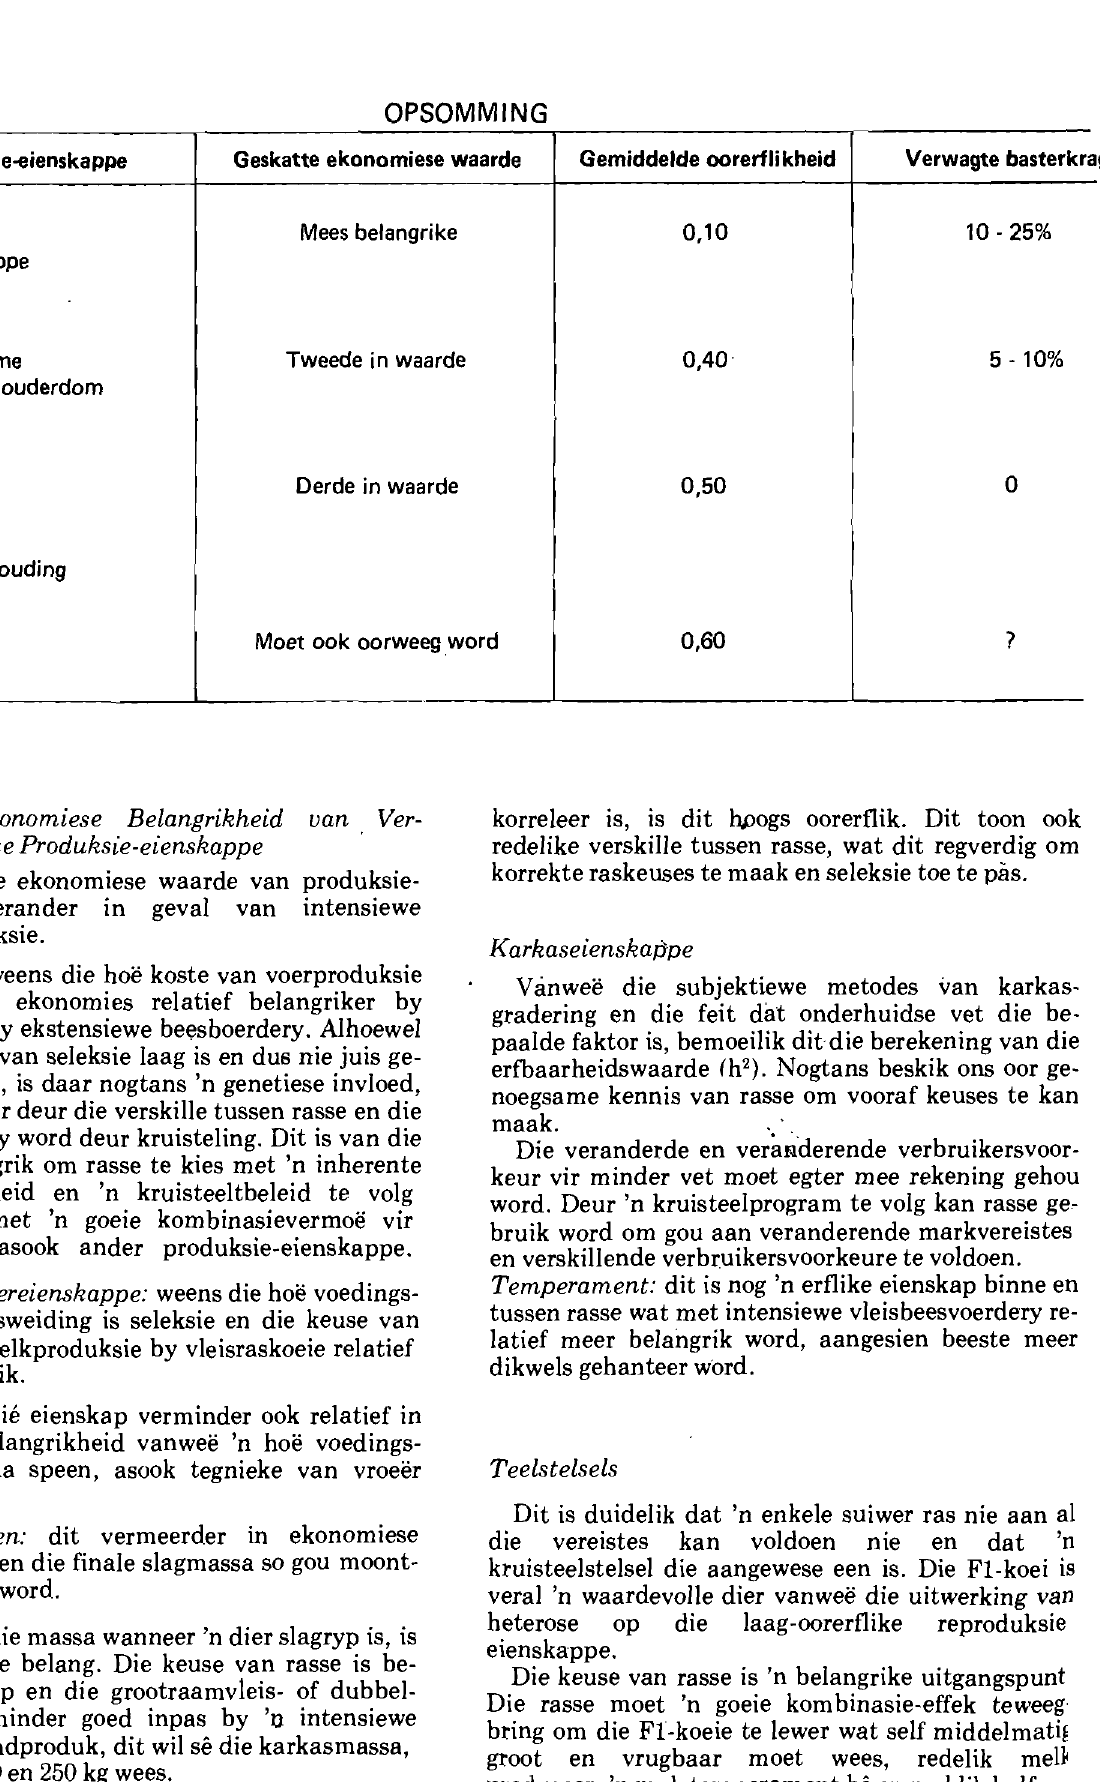
markingstelsel wat gevolg gaan word